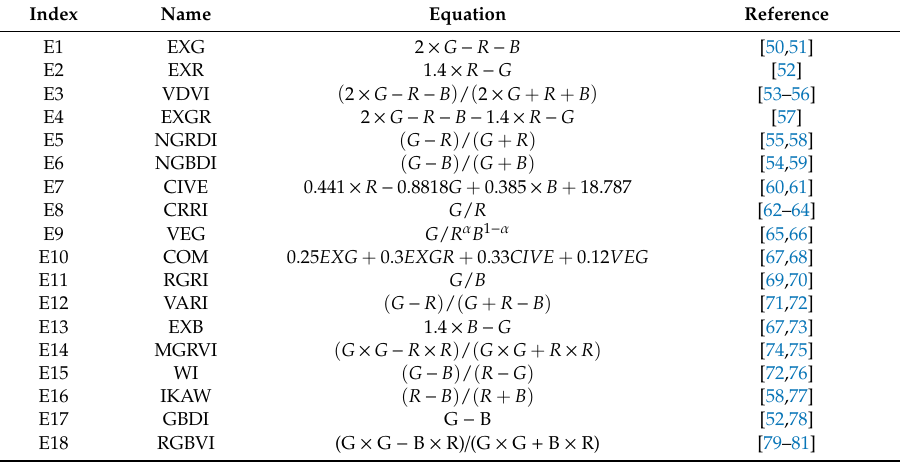
Table 1. The VI evaluated in this study. R, G, B indicated normalized red, green, and blue bands, respectively. Note: α was a constant as